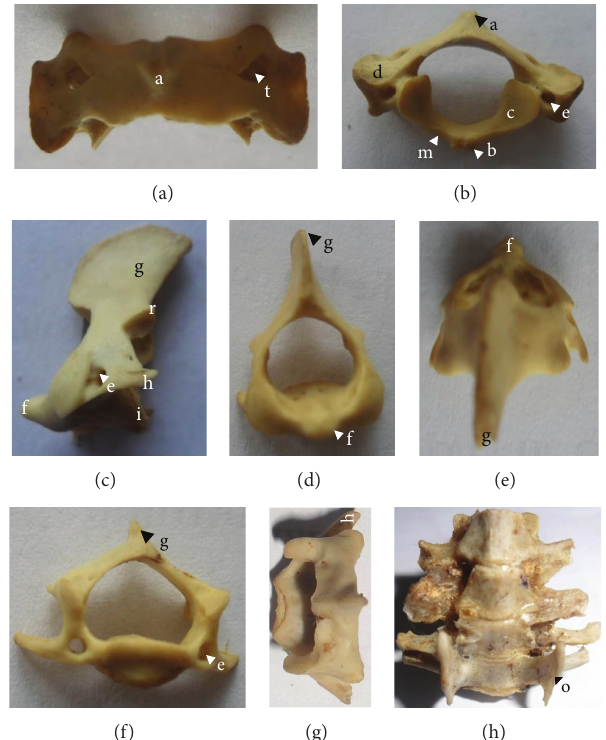
Figure 1: (a) and (b) dorsal and cranial views of the atlas bone, respectively; (c), (d), and (e) lateral, cranial and dorsal views of the axis bone, respectively; (f) and (g): dorsal and cranial views of the typical cervical vertebrae, respectively; (h) ventral view of C4–6 cervical vertebrae. a: dorsal tubercle, b: ventral tubercle, c: cranial articular surface, d: wing of atlas, e: transverse foramen, f: odontoid process, g: spinous process, h: transverse process, i: vertebral body, m: ventral arch, o: cervical rib, r: caudal articular process, and t: alar